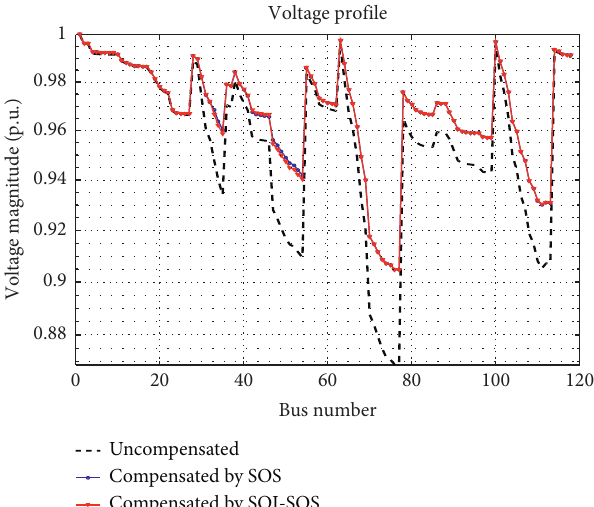
Figure 17: Voltage profile of the 119-bus system before and after compensation with the CP load model at 100% loading.